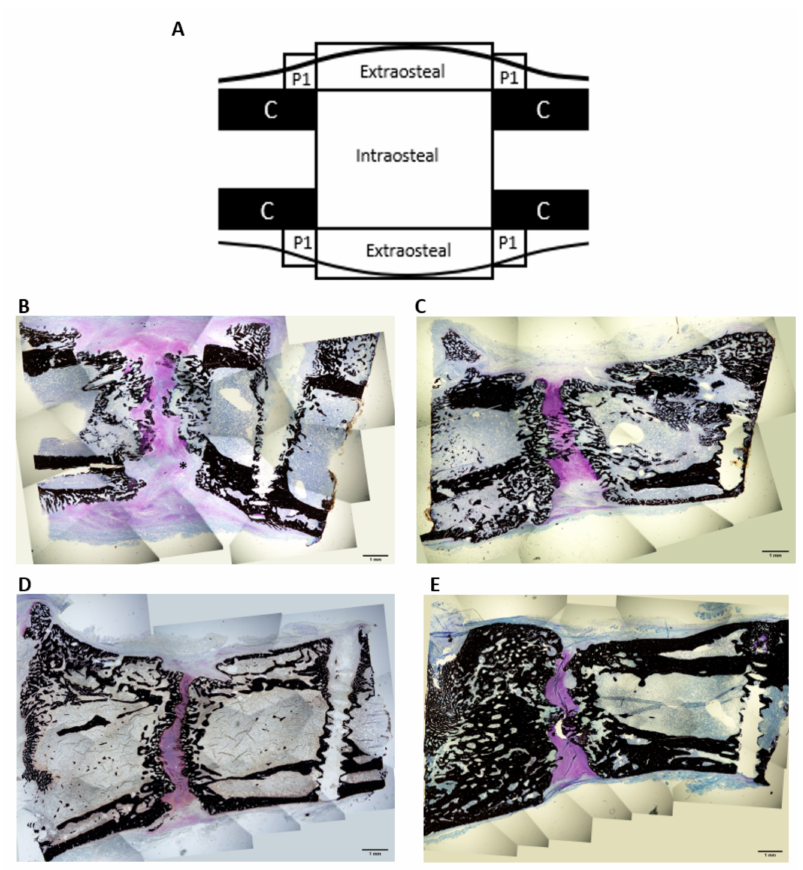
Figure 4. Histological images of the distracted callus at low magnification ( × 4) 31 days post-surgery ( B , C ) and 66 days post-surgery ( D , E ) in control group ( B , D ) and G-CSF group ( C , E ). ( A ) Region of interest (ROI) diagrams for histomorphometry analyses. ( B ) In the intraosteal region, fibrous tissue is still present. Note that the trabecular network visible is thinner and less connected than in the G-CSF group. In the central zone, the mineralized tissue is mostly composed of calcified cartilage rather than osseous tissue. ( C ) A bony bridge is apparent inside the intraosteal region. An intense cartilaginous zone is seen in between the two fronts of mineralization. The trabecular network is more developed and thicker. ( D ) The gap between the two osteotomized femur extremities is filled with cartilaginous tissue. No bridging is observed. In the periosteal zone, the double cortices are separated by a large medullary space. ( E ) The two bony ends of the femur are connected by a bony bridge in the center of the gap. In the periosteal zone, the bone marrow fills a small space, the cortices are thick and sometimes merged. Histological analysis was performed on 4 control animals and 4 G-CSF animals at each time. * = fibrous